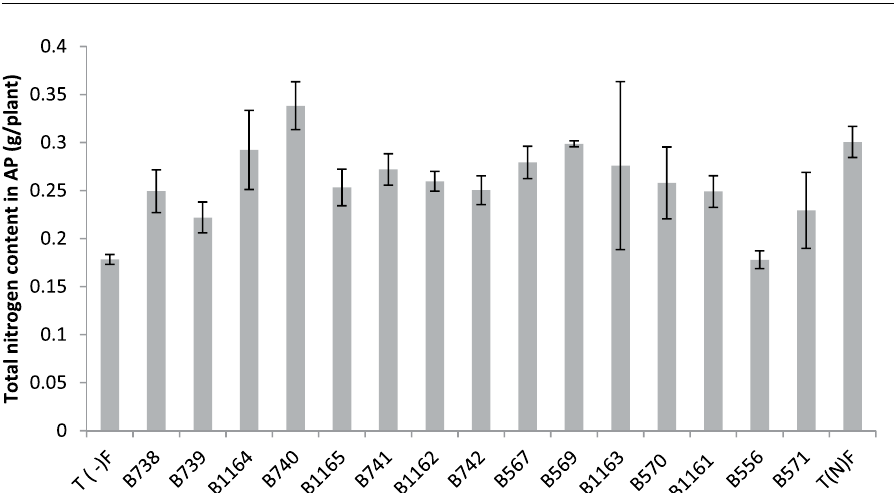
Fig. 4. Total nitrogen content in the aerial parts of broad bean plants fertilized and unfertilized inoculated with different strains of Rhizobium obtained from nodules of legumes isolated from Fez city and its regions. All data represent the mean ± SD of 3